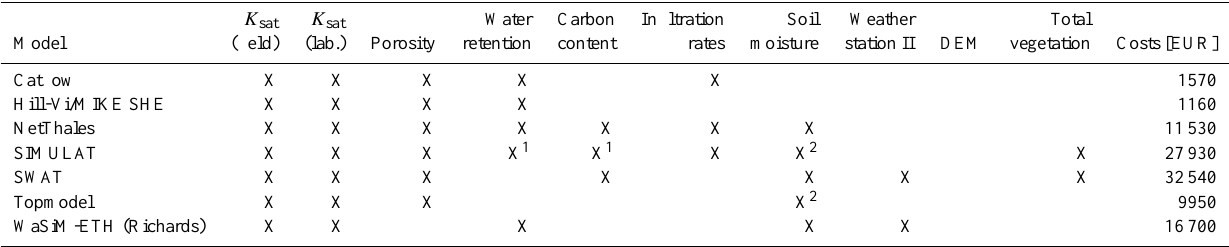
Table 6. Data chosen by the modeller for the third prediction. K sat K